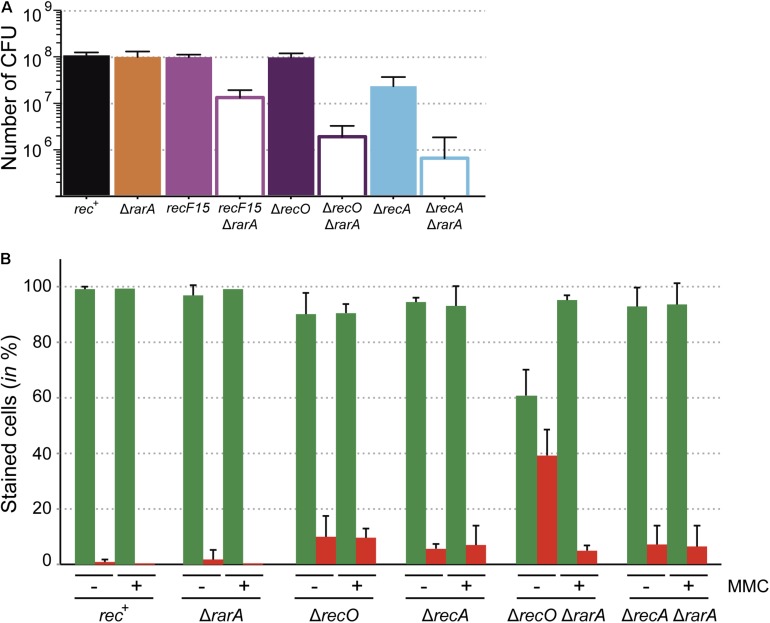
Growth defects of the ΔrarA recF15, ΔrarA ΔrecO and ΔrarA ΔrecA strains. (A) Cells were grown in NB to reach exponential phase (OD560 = 0.4) serially diluted, plated on NB agar, incubated ON and counted as CFU. (B) Cells were grown in NB to reach exponential phase (OD560 = 0.4) and divided in two aliquots (lacking [–] and containing 3 μM MMC [+]). The cultures were incubated for further 30 min and then cells were stained with SYTO 9 (green bar) and PI (red bar) to count the number of live and dead cells respectively. Percentage of SYTO 9- and PI-stained cells are indicated. 100% corresponds to the sum of green and red cells. The results are the average of at least three independent experiments and standard errors of the mean are indicated.